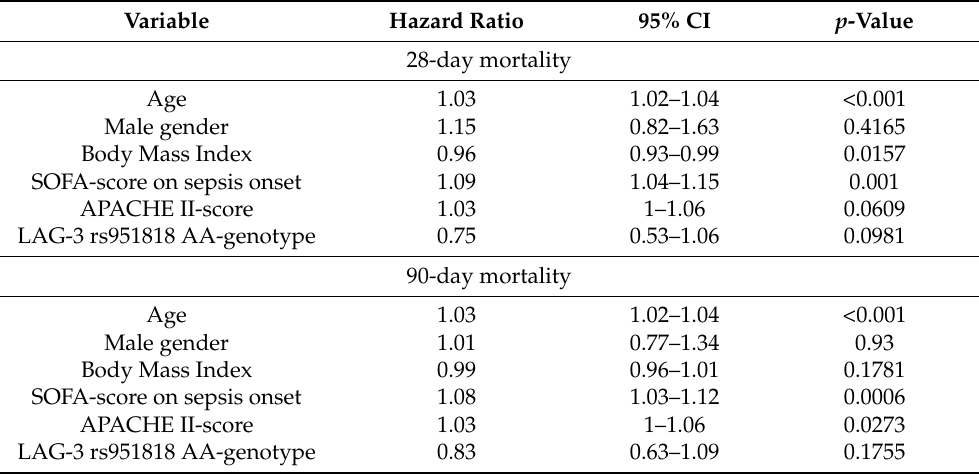
Table 3. Multivariate Cox regression analysis with regard to 28-day and 90-day